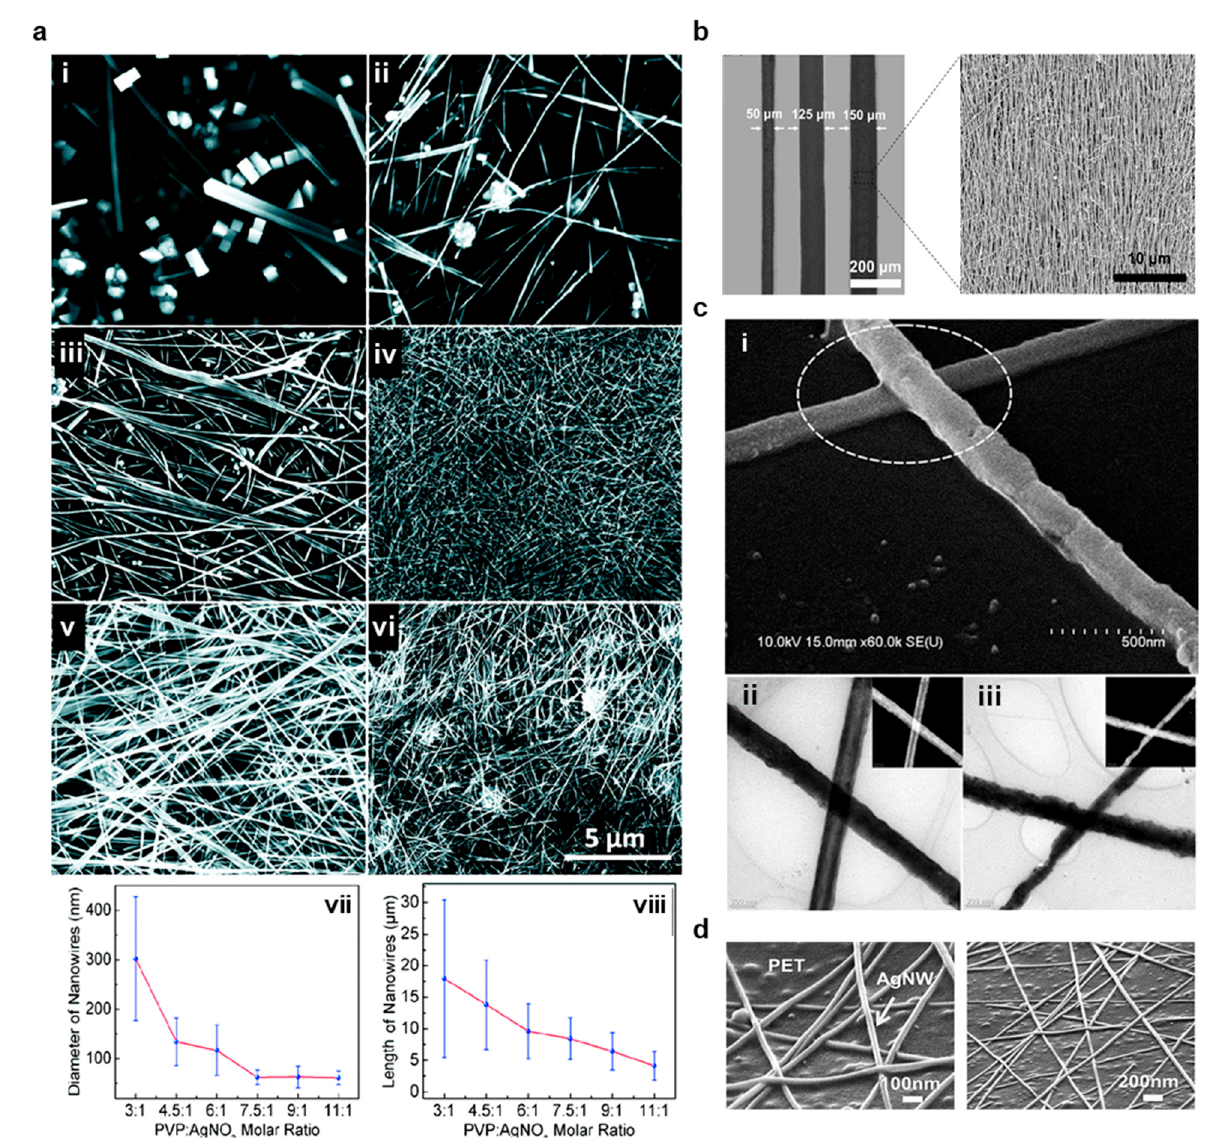
Figure 7. Metal nanowire synthesis, printing, and welding. ( a ) SEM images of Ag nanowires synthesized at different PVP:AgNO3 molar ratios of ( i ) 3:1, ( ii ) 4.5:1, ( iii ) 6:1, ( iv ) 7.5:1, ( v ) 9:1, and ( vi ) 11:1. All scales are the same. Changes in